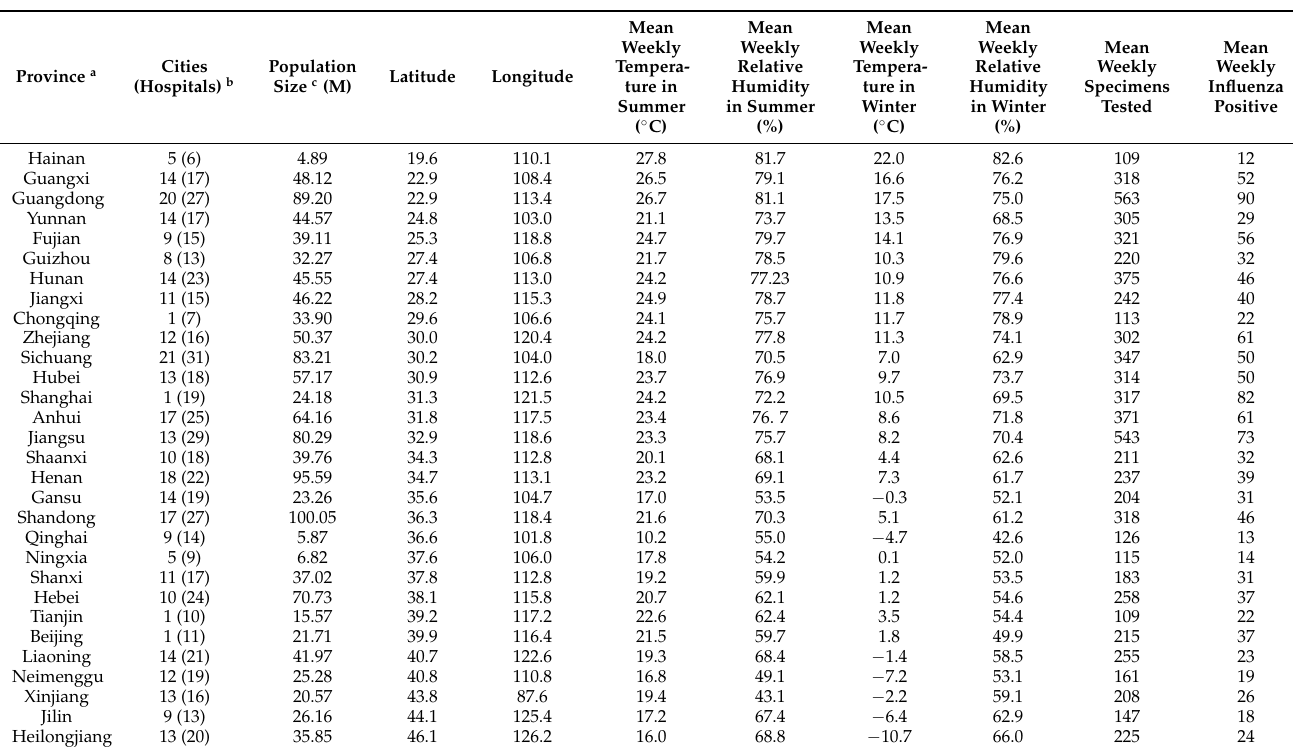
Table 1. Background characteristics of the 30 provinces involved in influenza surveillance and information on influenza sampling intensity, 2010–2018, China.